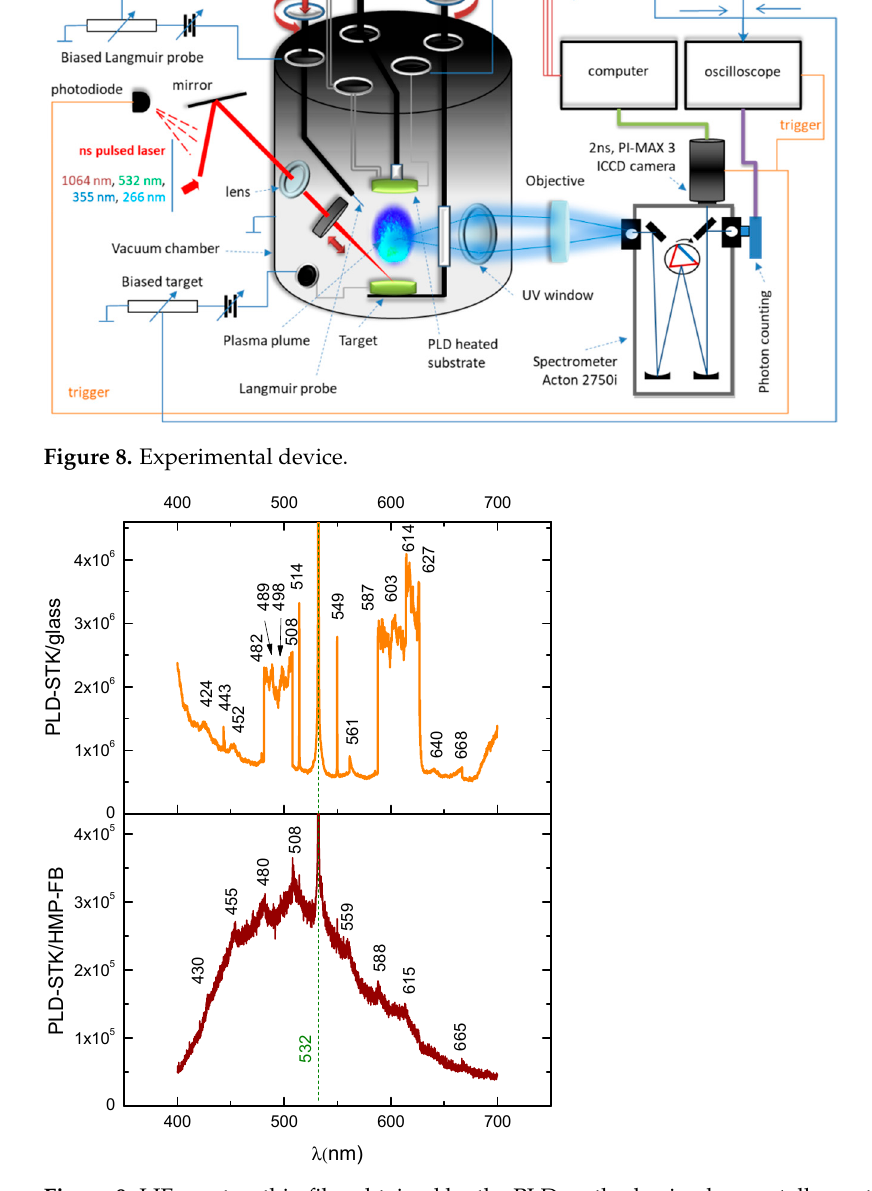
Figure 9. LIF spectra: thin film obtained by the PLD method using hemp stalk as a target deposited on different substrates: hemp fabric (PLD-STK/Hemp); glass slab (PLD-STK/glass). Table 3. The fluorescence peaks of the thin films of PLD-HMP-STK/HMP-FB and PLD-HMP- STK/Glass.